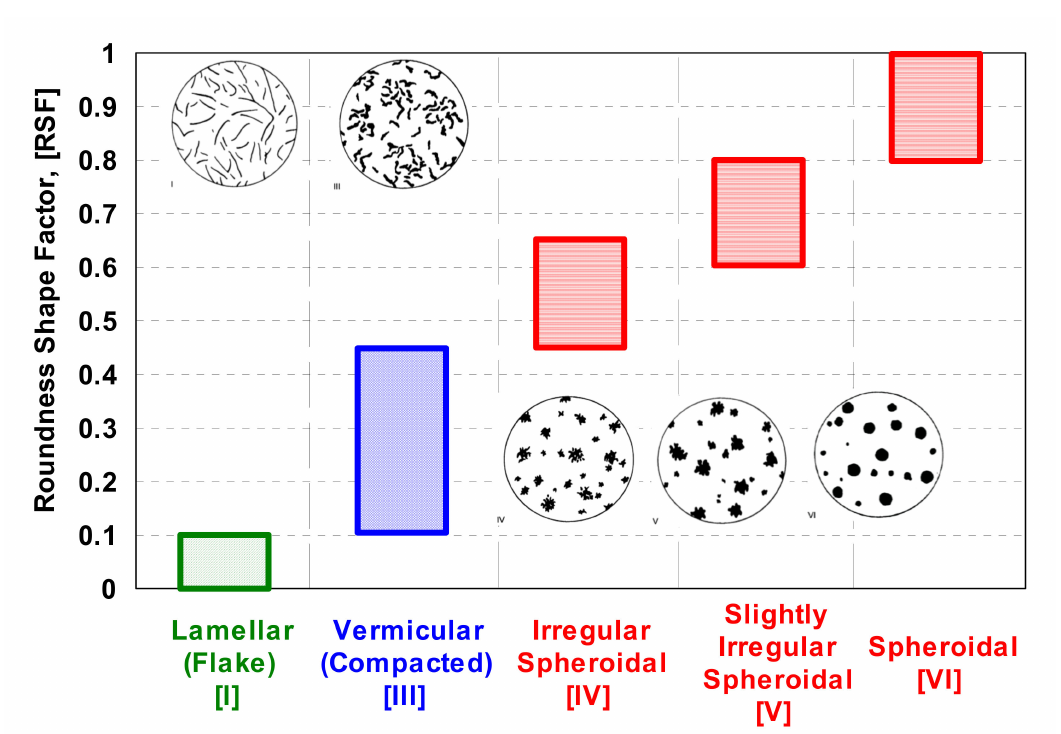
Figure 11. Representative graphite forms (ISO 945) characterized by Roundness Shape Factor